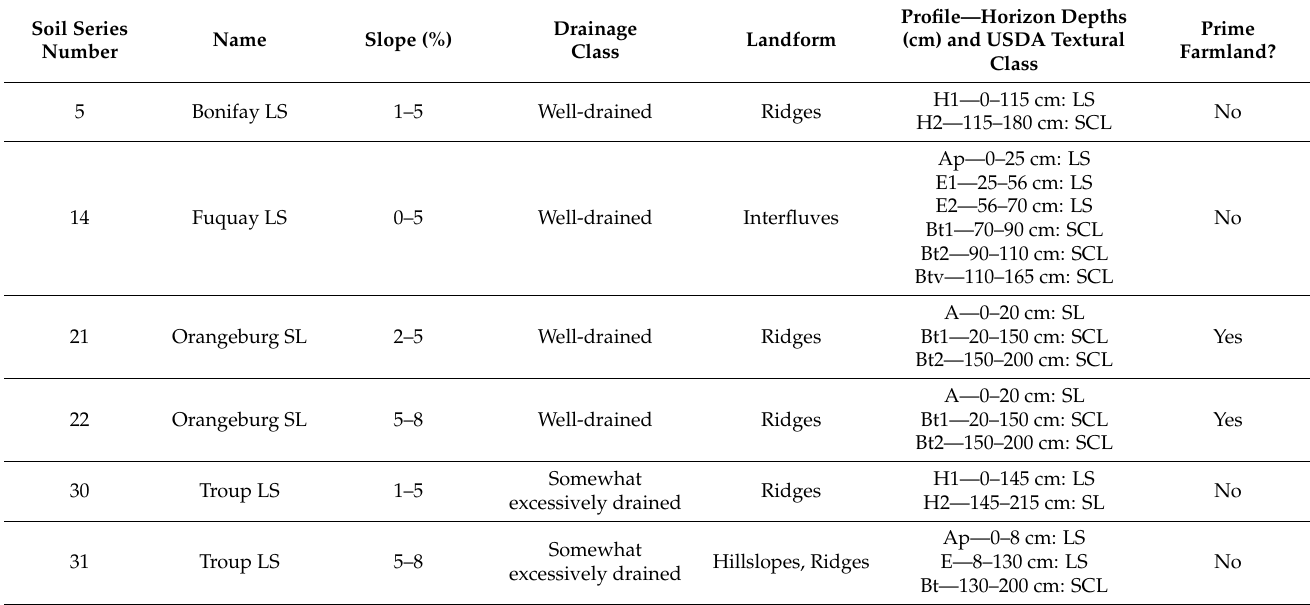
Figure 2. Map ( a ) showing field observation locations (red dots), field boundaries (black lines) and soil series (colors). ( b ) Aerial photo showing soil series boundaries (orange lines) and numbers, de ‐ tails of soil series based on numbers in https://websoilsurvey.nrcs.usda.gov/app/WebSoilSur ‐ vey.aspx (accessed on 14 August 2022) given in Table 1.